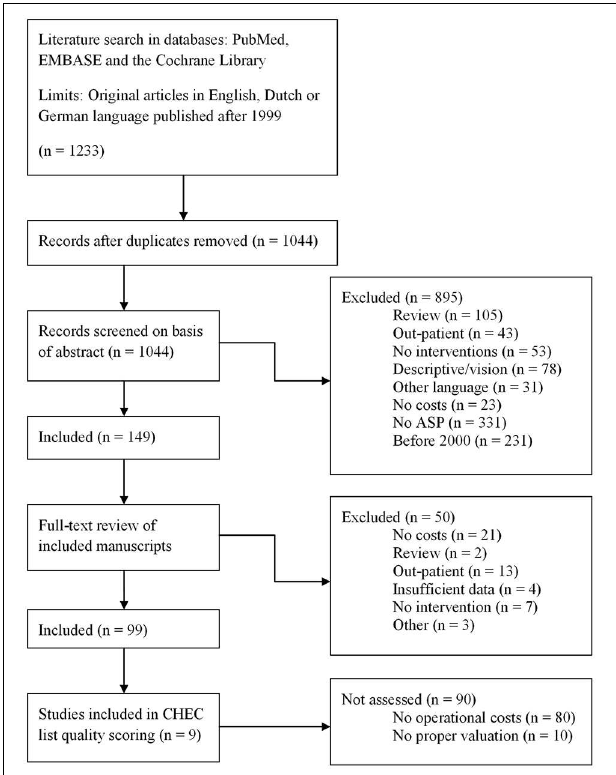
FIGURE 1 | Flow chart of the search method. The followed search method as performed on 4 November 2014.